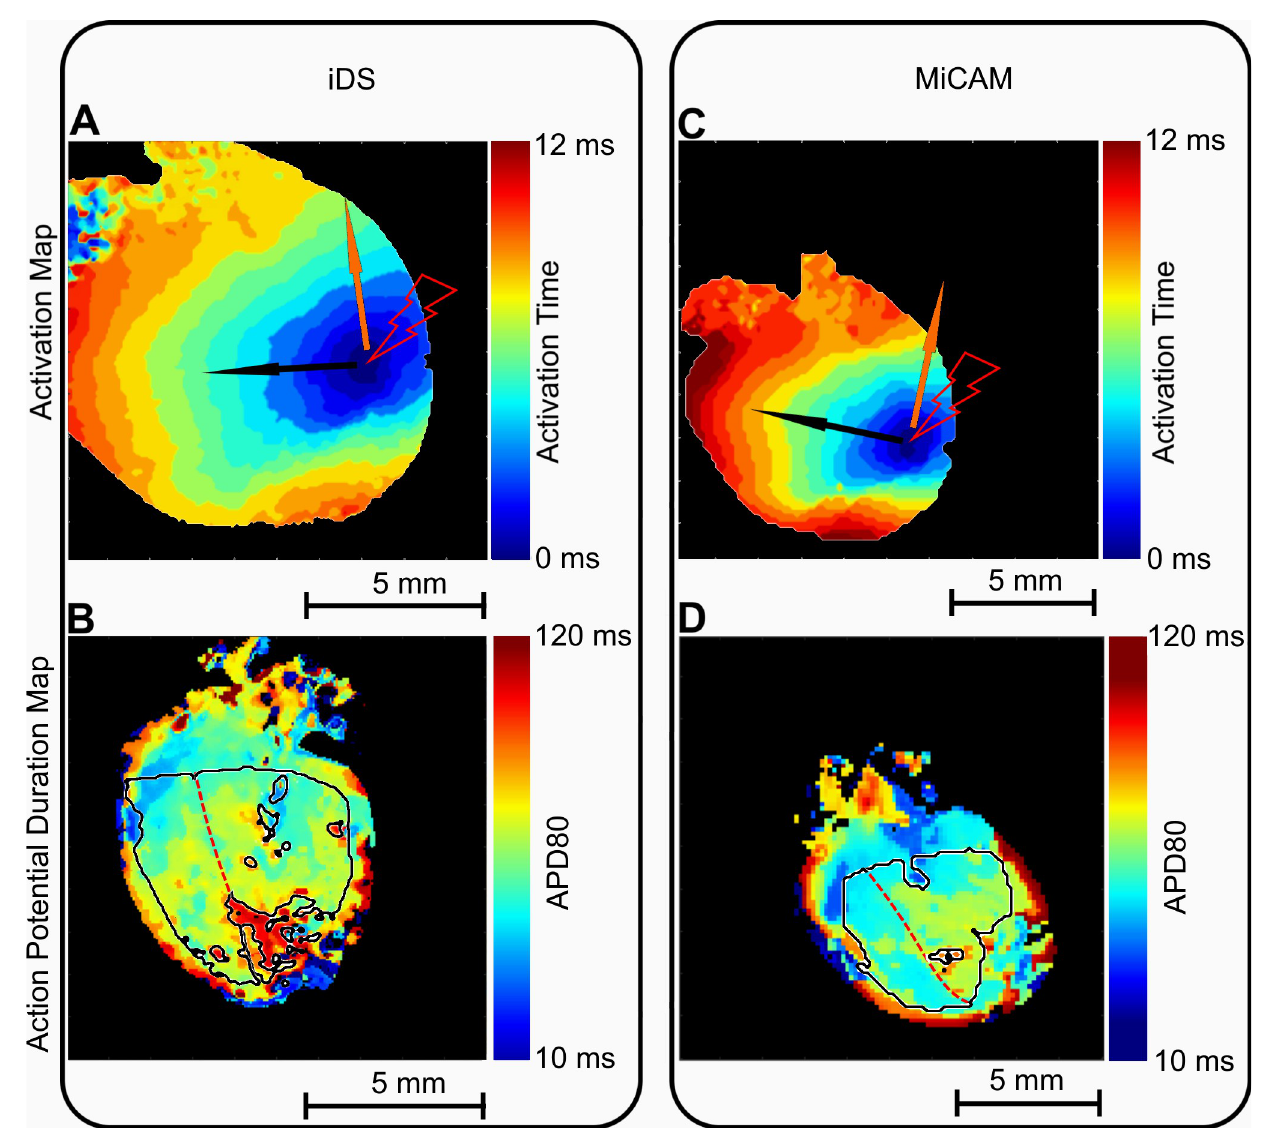
Fig 7. Comparison of activation maps and APD maps recorded by iDS and MiCAM. (A) Mouse heart activation sequence measured by iDS camera. (B) Mouse heart APD map measured by iDS camera. (C) Activation sequence measured by MiCAM camera. (D) APD map measured by MiCAM camera. Black line marks the region that was used for APD analysis, the region was divided into left and right ventricle as shown by red dashed line. Pacing electrode location is marked by the lightning symbol, black and orange arrows mark the directions for longitudinal and transversal conduction velocities,